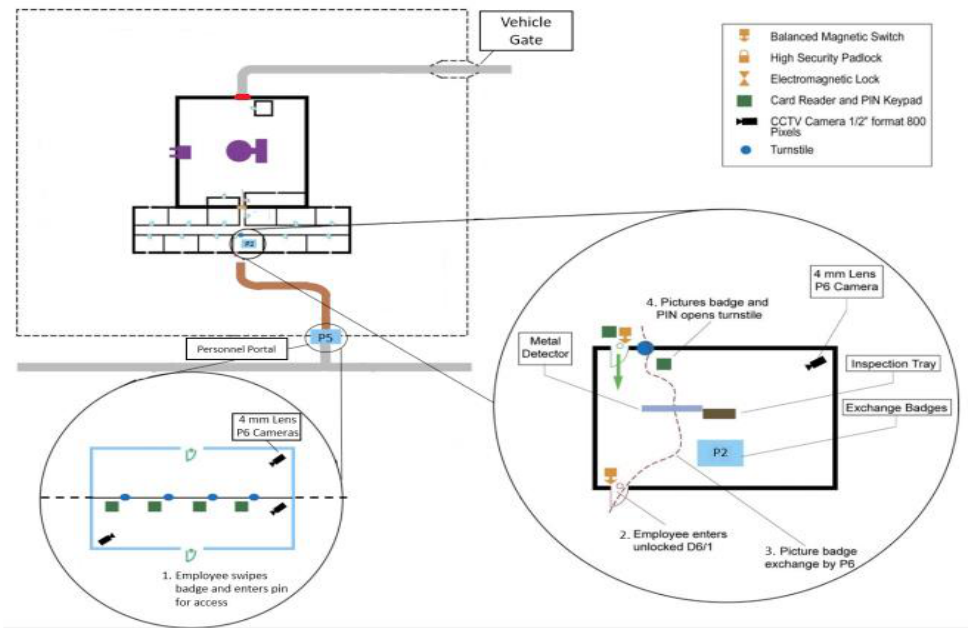
Figure 3. MTR access control plan as described in the datebook.